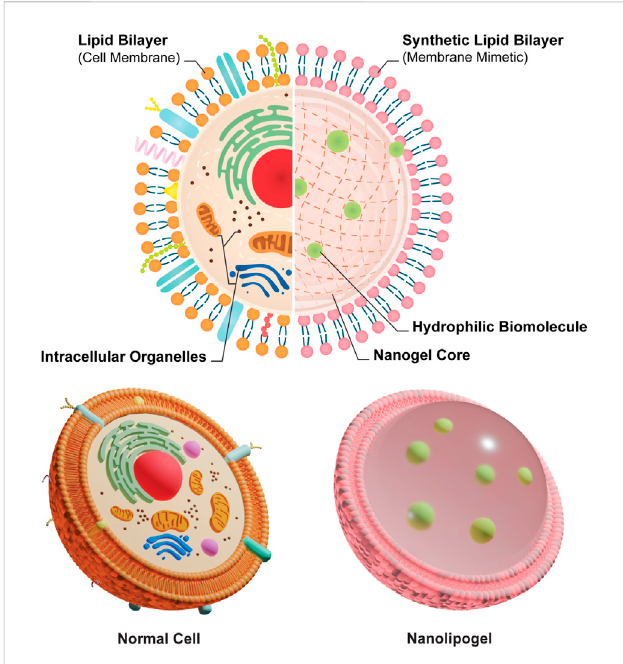
FIGURE 1 Schematics of the comparison between normal cell and cell mimetic